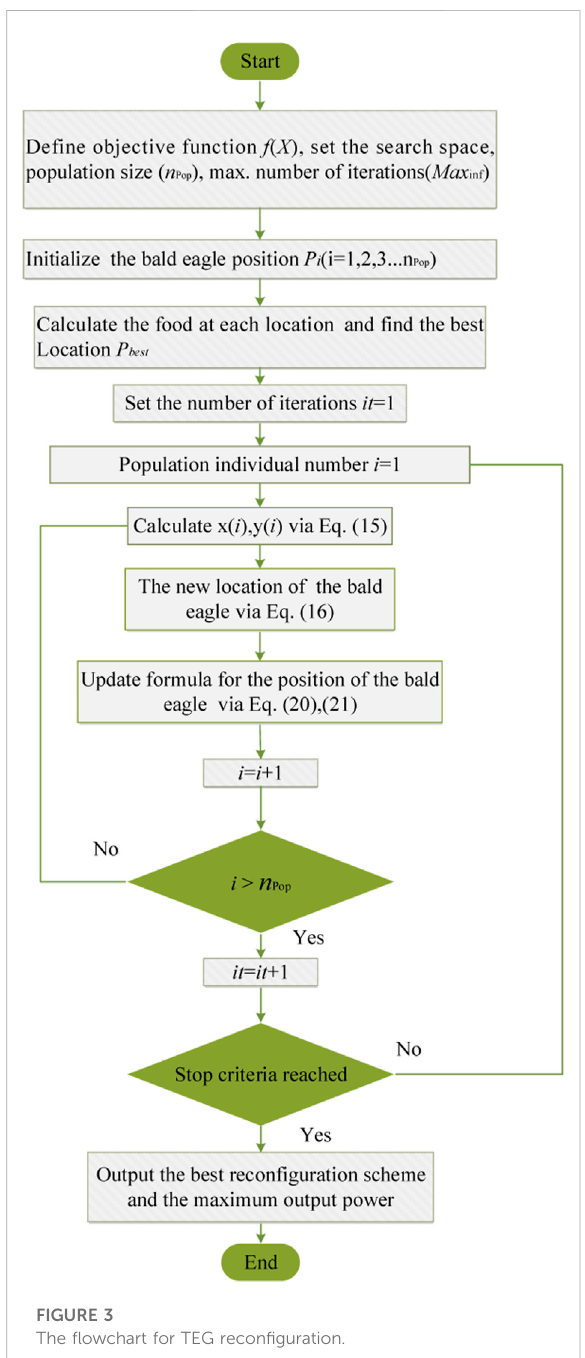
FIGURE 3 The fl owchart for TEG recon fi